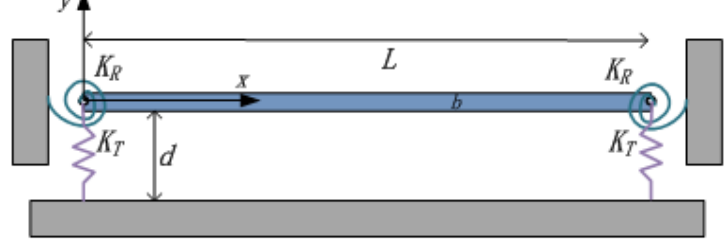
Figure 2. Schematic representation of an electrically actuated beam with compliant